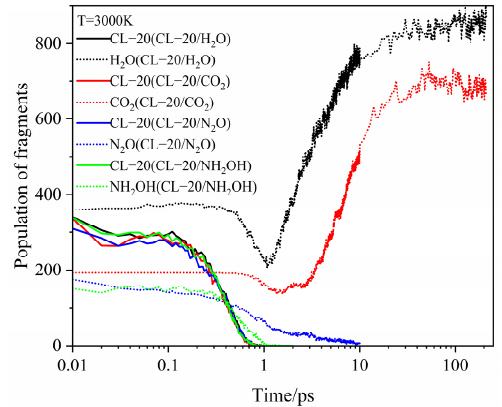
Figure 8. Evolution curves of the host and guest molecules for CL-20/H 2 O, CL-20/CO 2 , CL-20/N 2 O, CL-20/NH 2 OH at 3000 K. Thick trendline corresponds to the actual concentration data of correspond- ing matching